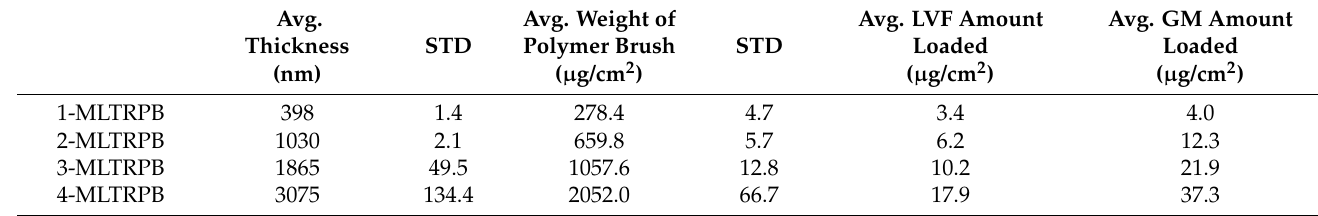
Table 1. Physical properties of MLTRPB on Ti